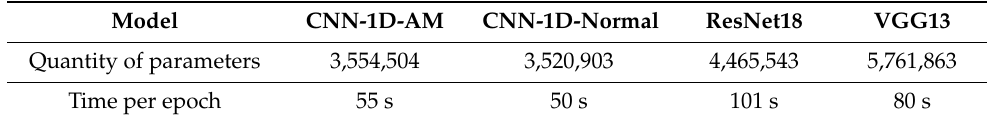
Table 6. The number of parameters and training time per epoch for convolutional neural network